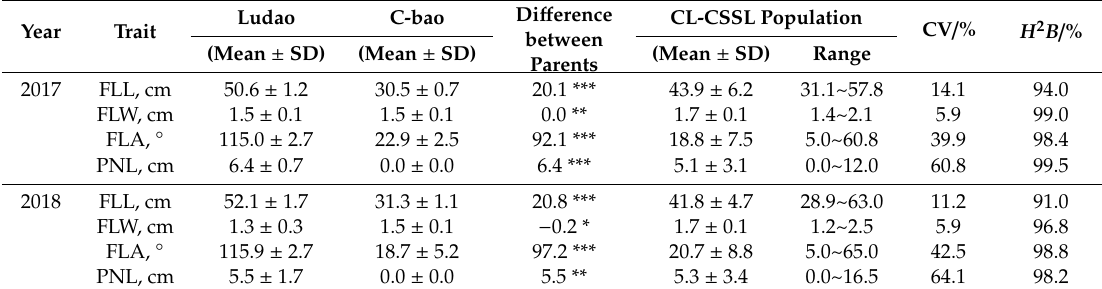
Figure 4. Frequency distribution of donor segments from Ludao in the CL-CSSL population. 3.2. Phenotypic Variation of the Four Outcrossing Traits in the CL-CSSL Population Descriptive statistics between two parents and CSSLs population related to the four outcrossing traits are listed in Table 2. The frequency distribution of the four traits in the CL ‐ CSSL population Table 2. Basic statistics of the phenotypic values of four outcrossing traits in the CL-CSSL population and its parents in two